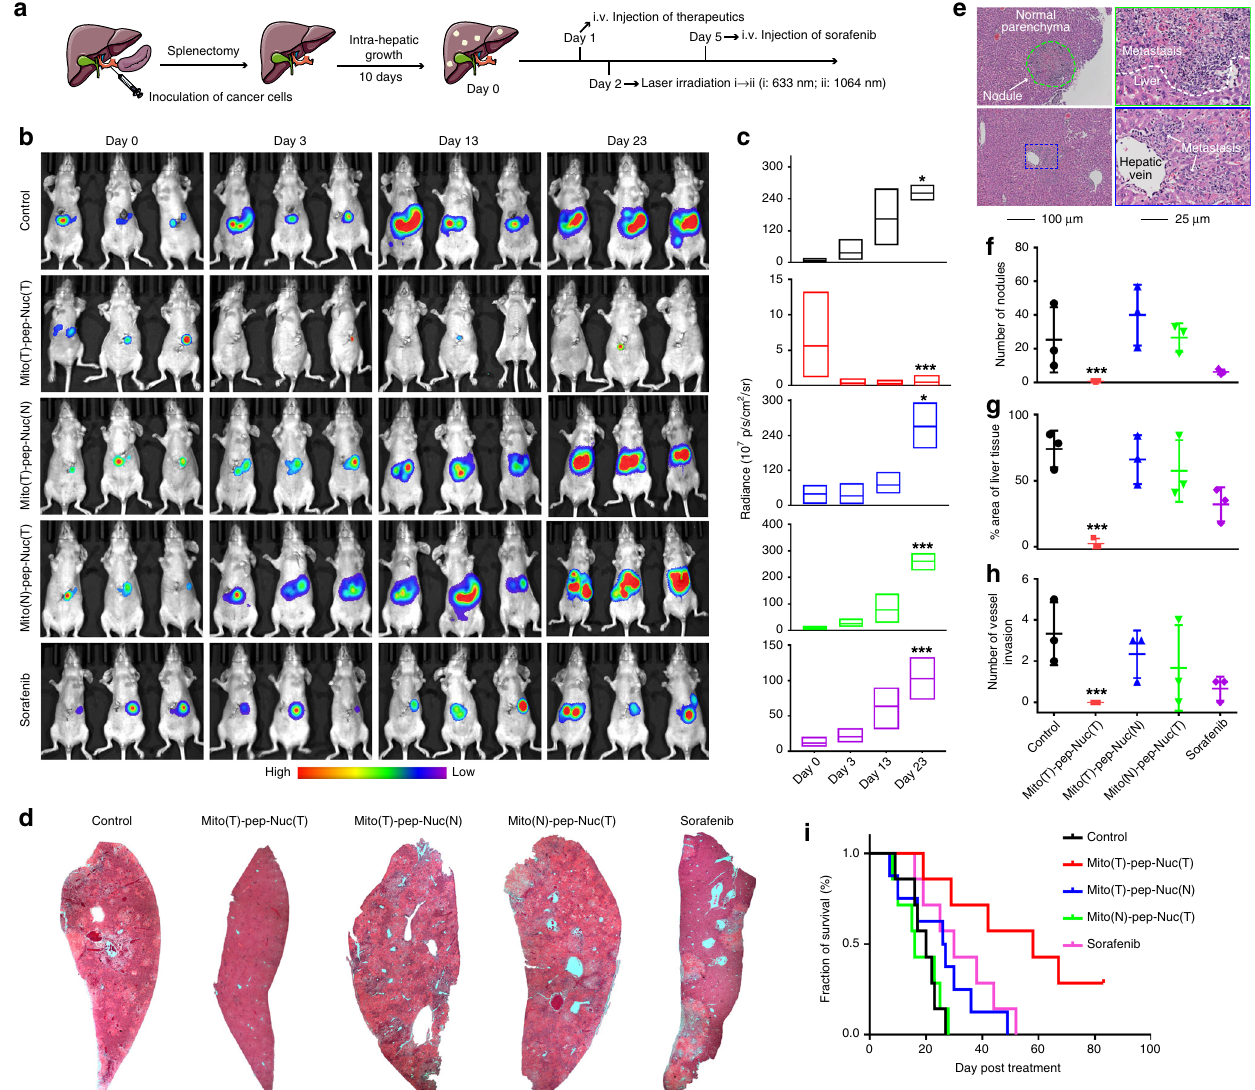
Fig. 9 In vivo anti-metastasis effect. a A schematic showing the procedures of in vivo experiments ( n = 7 in each group). b Bioluminescence graphs of mice at different time points after receiving the treatments with the radiance of liver tissues quanti fi ed and shown in c ( n = 3). In the box plot, the upper and lower quartile as outlined by top and bottom boundary were divided by line showing the median value. d Necropsy of representative liver tissues collected at day 30 or the day they died if earlier than day 30. (A full spectrum of necropsy is shown in Supplementary Figs. 26 – 30). e Representative micrographs with H&E staining showing the pathological features of liver metastasis and pan-cancer normal parenchyma. The micrographs on the right panel show the details of regions that have been highlighted with either the green circle or blue box at a higher magni fi cation. f Number of nodules that existed in an observation area (×10, average of ten fi elds for each mouse). g Area of the liver tissue that was occupied by metastasis. h The number of cases of invasion into liver vessels ( n = 3). Median value was shown as line in the middle of the plot. i Survival pro fi les of mice received different treatments during an observation period of 80 days ( n = 7). Data are presented as mean ± s.e.m. P values were calculated by one-way ANOVA (*** p < 0.005, * p <